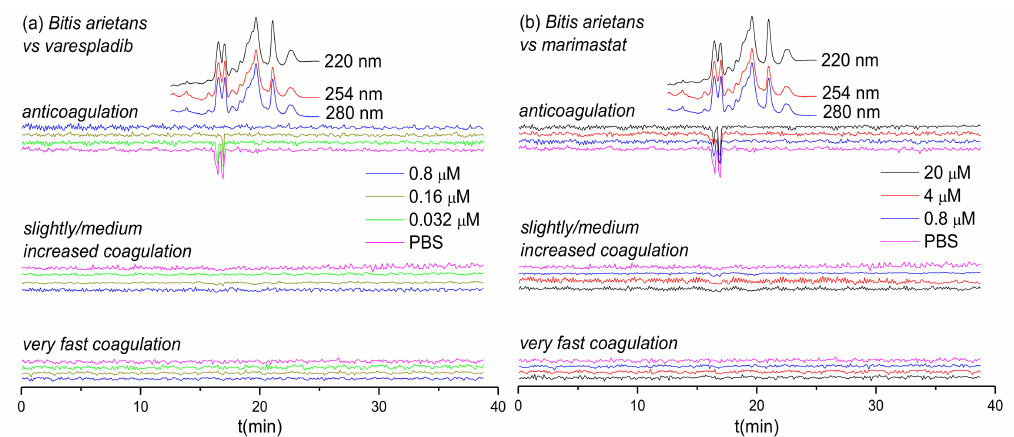
Figure 4. UV absorbance chromatograms and reconstructed coagulopathic toxicity chromatograms of nanofractionated toxins from B. arietans venom in the presence of di ff erent concentrations of ( a ) varespladib and ( b )